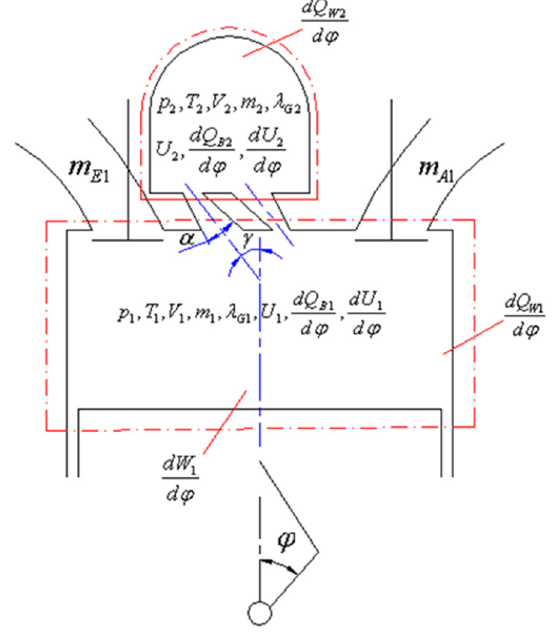
Figure 2. Thermodynamic system of the swirl chamber diesel engine.